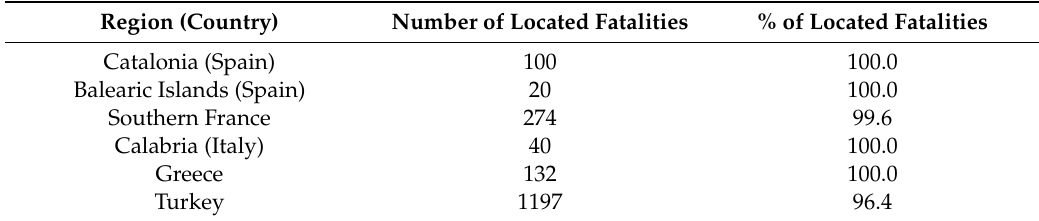
Table5. Numberandpercentageoffatalitieswithaccurateandvalidatedgeolocationpercountry / region.